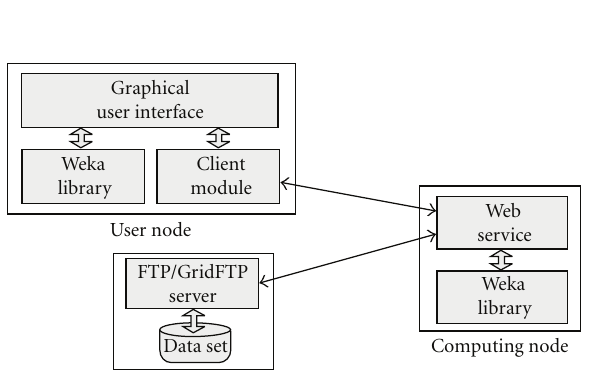
Figure 6: Nimbus components.